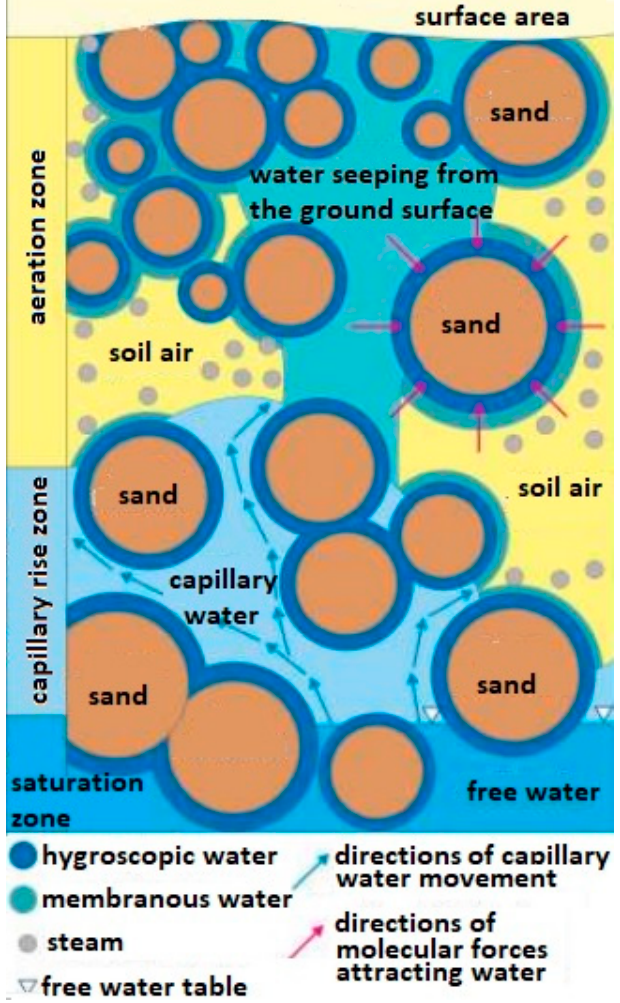
Figure 1. Diagram of types of water occurring in the ground. Source—educational materials Sławomir Dmowski.